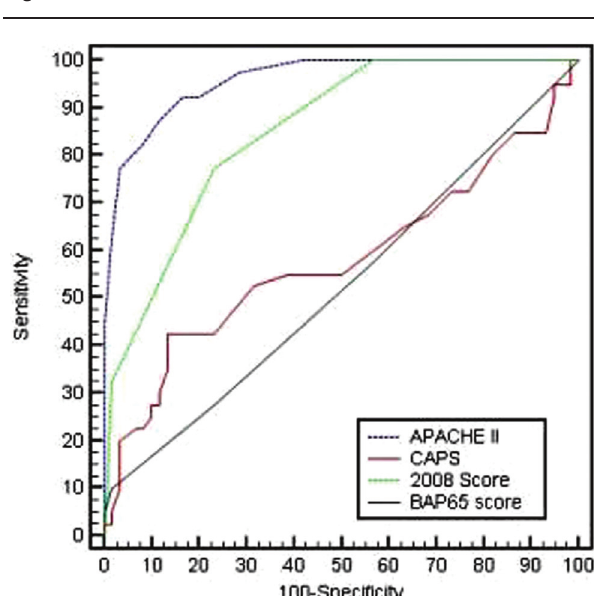
ROC curve for APACHE II, CAPS, BAP65, and 2008 scores to predict the need for mechanical ventilation. APACHE, Acute Physiology and Chronic Health Evaluation; BAP65, elevated blood urea nitrogen, altered mental status, pulse more than 109/min, age more than 65 years; CAPS, chronic obstructive pulmonary disease (COPD) and Asthma Physiology Score; ROC, receiver